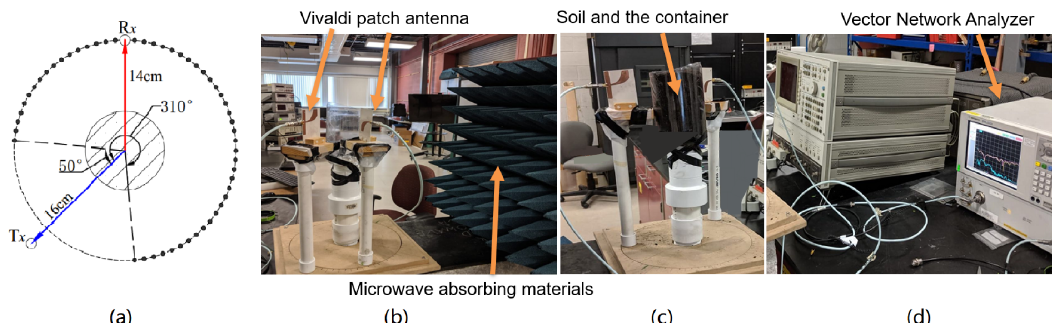
Figure 4. ( a ) Schematic of experimental setup showing the scanning location points spaced angularly at 10 ◦ with Tx as transmitter and Rx as receiver. The experimental setup showing ( b ) Vivaldi- style patch antennas with a centrally located sample container containing soil and a carrot with a microwave absorber, ( c ) close view of soil container and two antenna supports of which one is mounted on a rotating base and ( d ) RF signal measurement equipment (VNA).